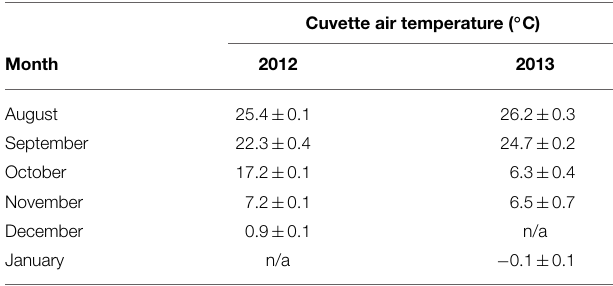
TABLE 1 | Cuvette air temperature measured during each measurement campaign, using the LI- 6400 XT gas exchange